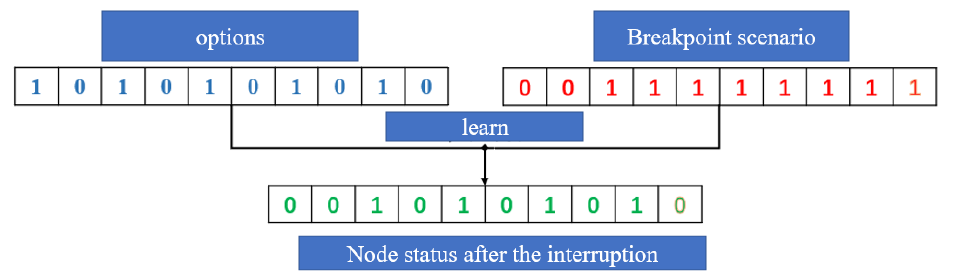
Figure 7. Interrupt point